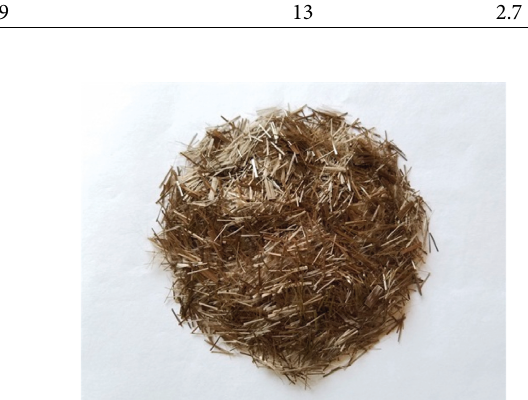
Figure 2: Photograph of basalt fiber.